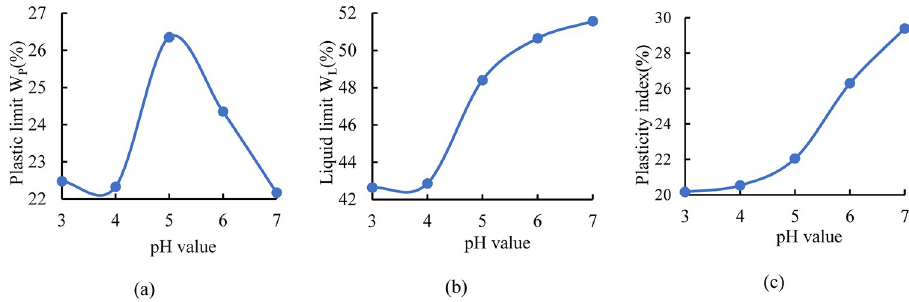
Fig 4. Liquid-plastic limit curves of expansive soil under different acidic